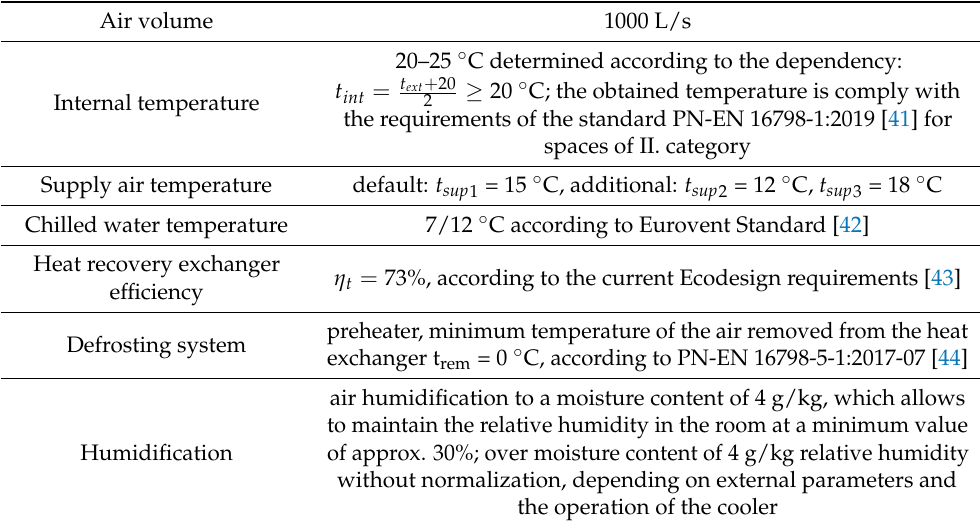
Table 5. Detailed parameters of the air treatment